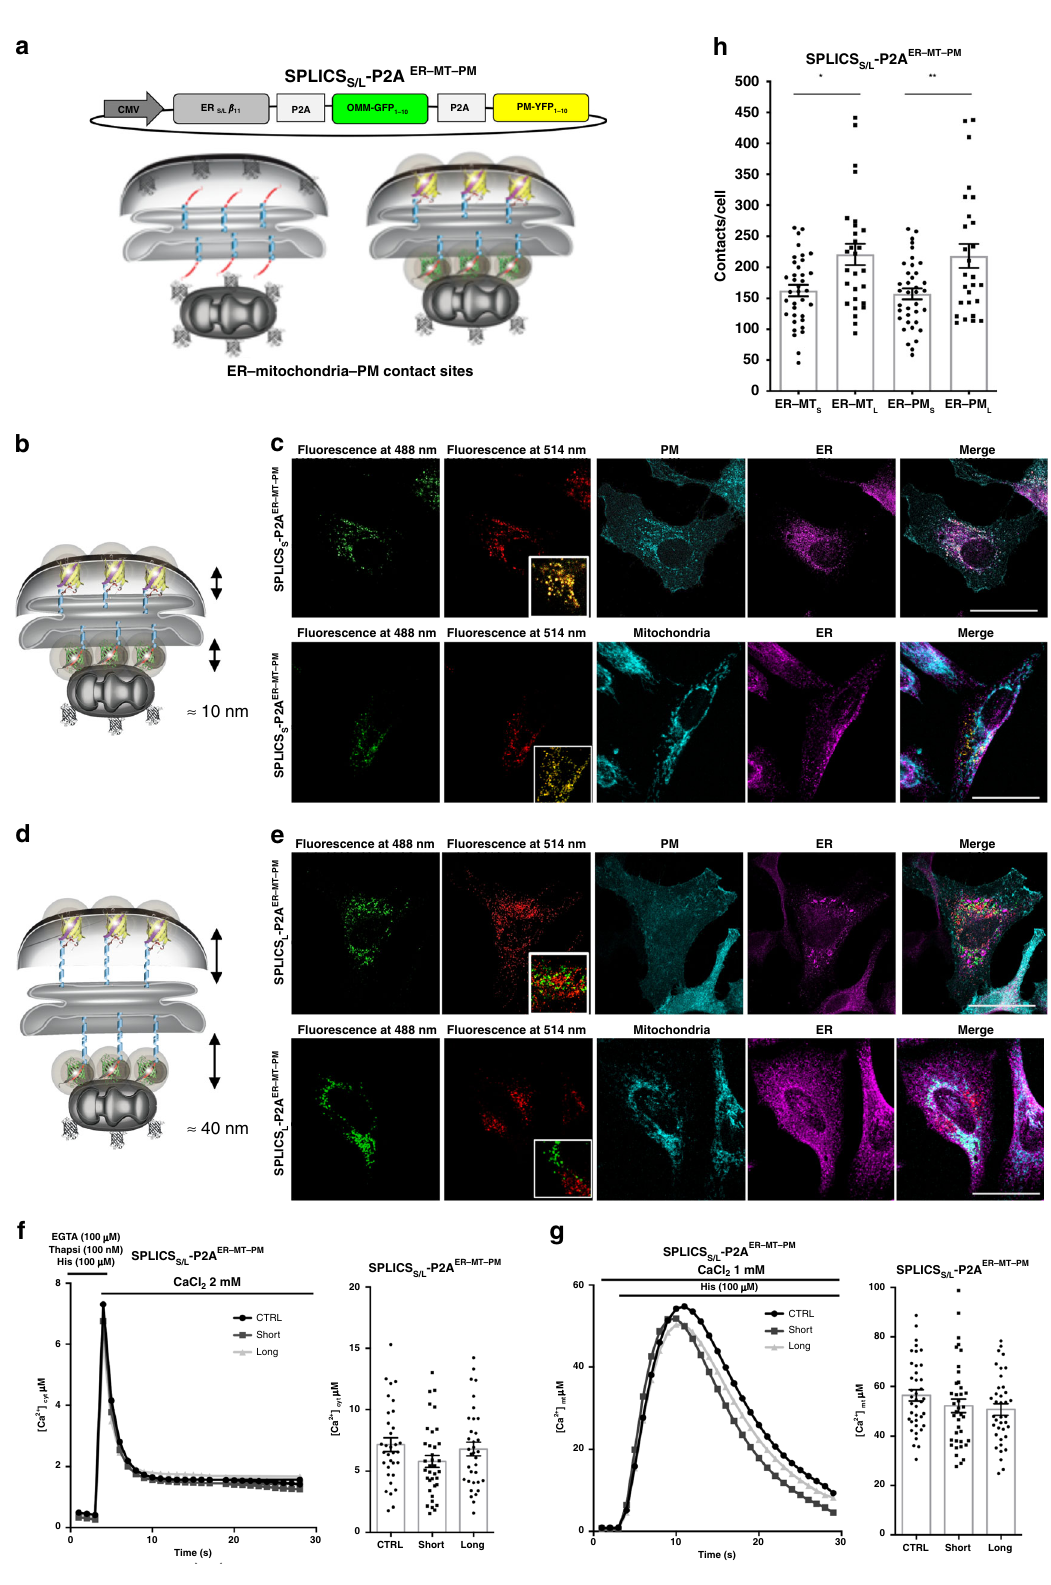
hippocampal neurons (Fig. 7d – f). In cultured HeLa cells, three different detection and tracking algorithms couples reported that the long-range ER – mitochondria interactions have lower persis- tence in time (lifetime, Fig. 6a – c and Supplementary Fig. 11a, b) but higher displacement (meant as the distance between